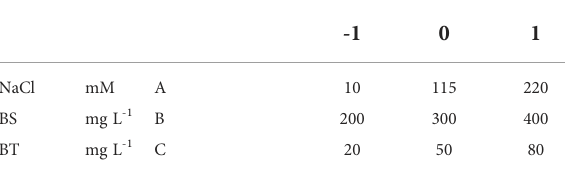
TABLE 1 Independent variables (NaCl, BS and BT concentration) and their levels used in the Box-Behnken design. Factors Units Coded symbols Range of variables